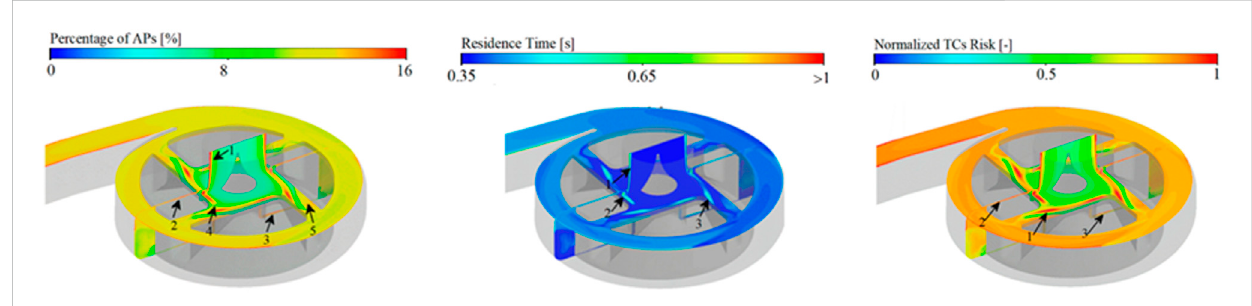
Thrombotic risks modelling. Quanti fi cation of thrombotic clots risk (right panel) upon activated platelet concentration (left panel), residence time (centre panel). Panel is modi fi ed from Li et al.,